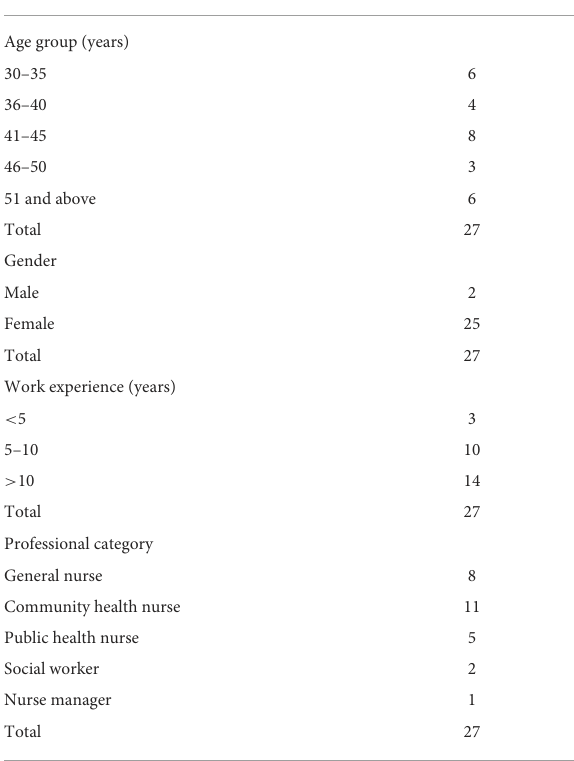
TABLE 1 Background characteristics of